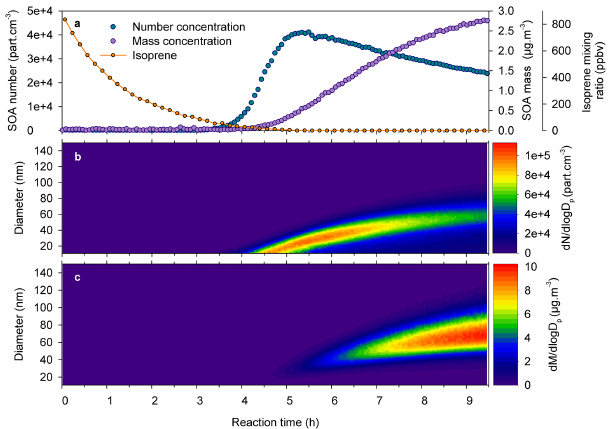
Figure 2. Time profiles of measured (a) SOA mass and number concentrations, (b) number size distribution and (c) mass size dis- tribution during isoprene photooxidation (experiment I280113) per- formed with no seeds and with HONO as OH source. A particle density of 1.4gcm − 3 was assumed (see